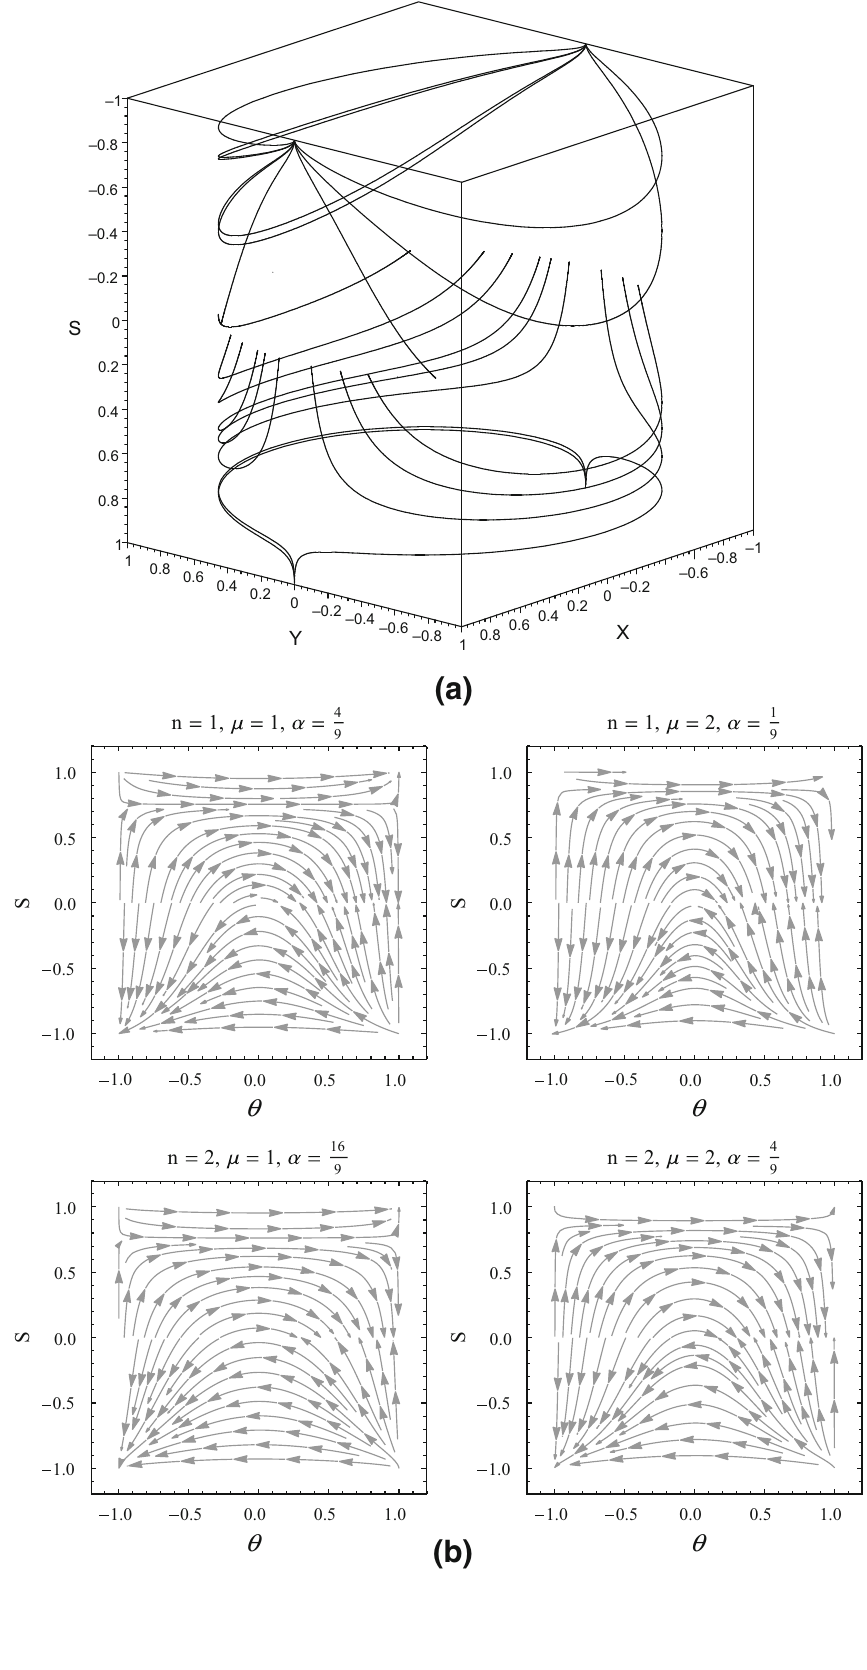
Fig. 16 a Compact phase portrait of (350), (351), (352) for the choice n = 2 ,μ = 1. b Dynamics on the cylinder at infinity given by Eqs. (354), (355) for some values of n